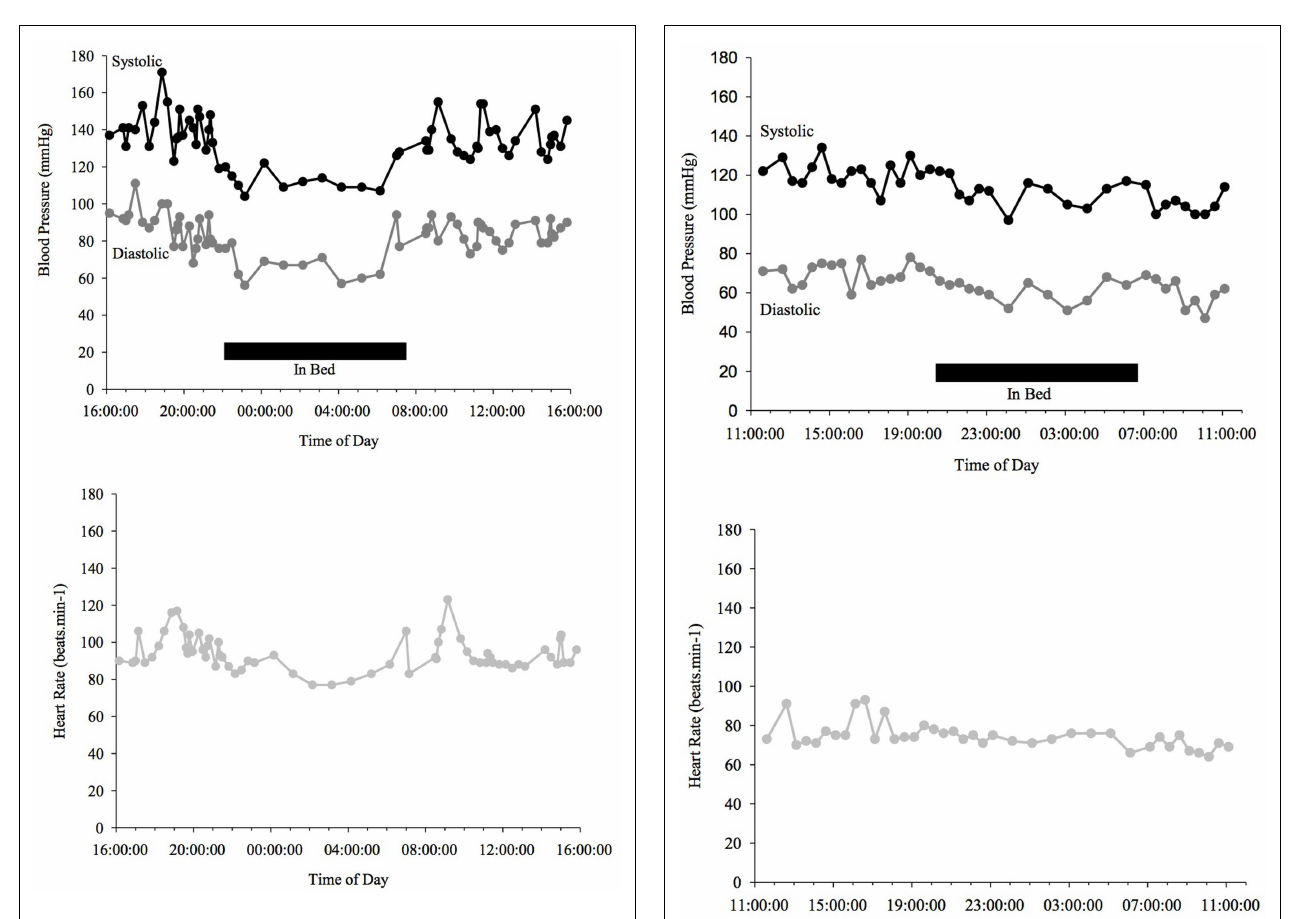
FIGURE 2 | Blood Pressure (upper line systolic, lower line diastolic) and heart rate profiles during 24hABPM of a PD patient; dipper, showing more than a 10% drop in BP at night time. Black bar indicates sleep. Peaks in BP relate to agitation or increased tremor.